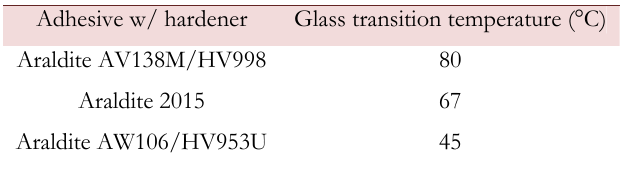
Table 2: Adhesives selected with indication of T